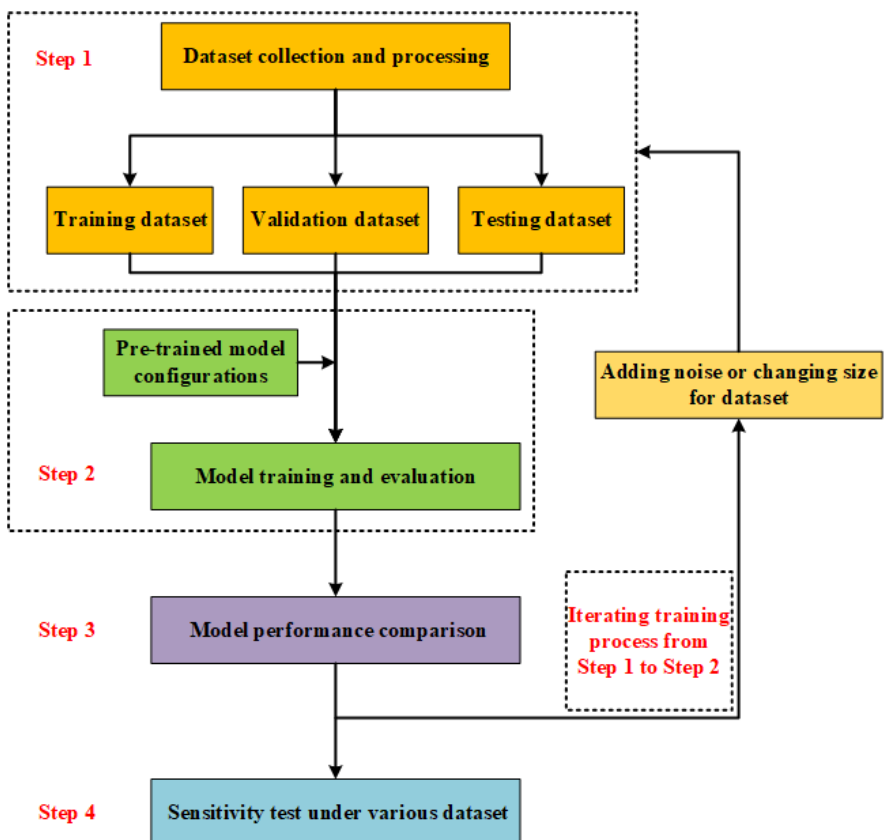
Figure 3. Developing flowchart regarding the optimal model for monitoring underwater gas leaks based on computer vision-based approaches. based on computer vision-based